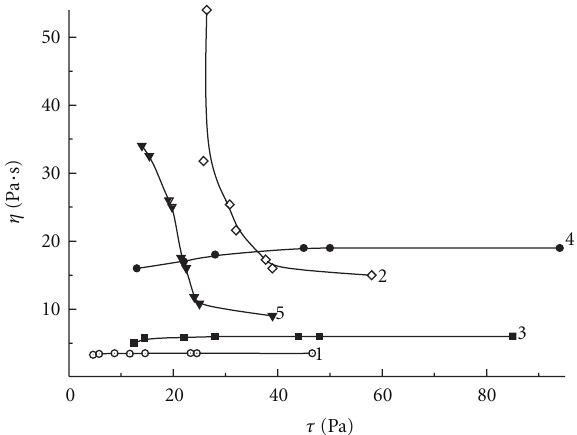
Figure 14: Viscosity versus shear stress for the 15 and 25% aqueous suspensions of the initial activated carbon (1, 2) and activated carbon modified with the Na-CAS (3, 4), respectively, and of the 15% suspension of the activated carbon modified with the starch